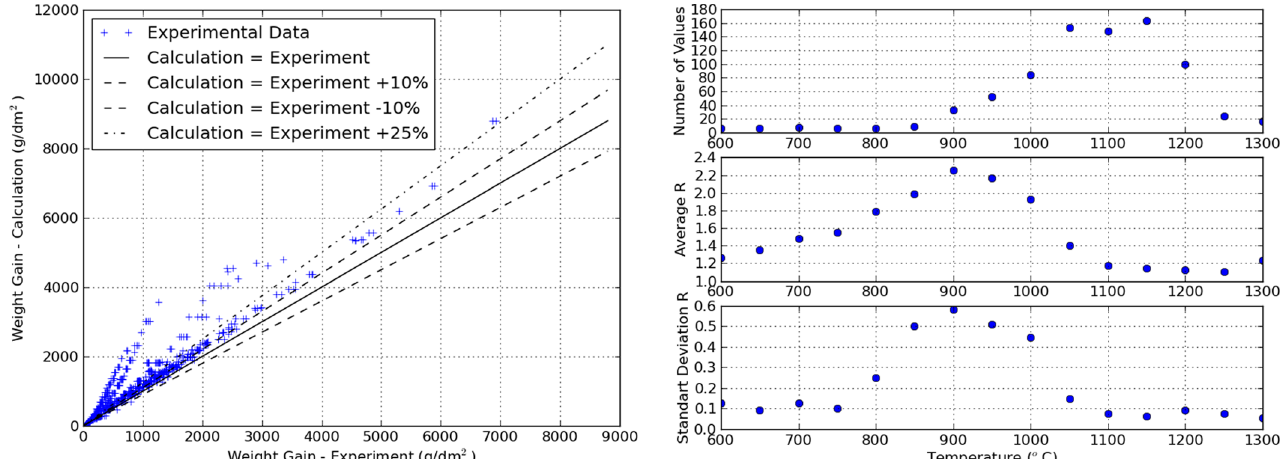
Fig. 9. Comparison of experimental and Cathcart-Pawel correlation data. Weight gain for all data (left) and R -parameter for each evaluated temperatures